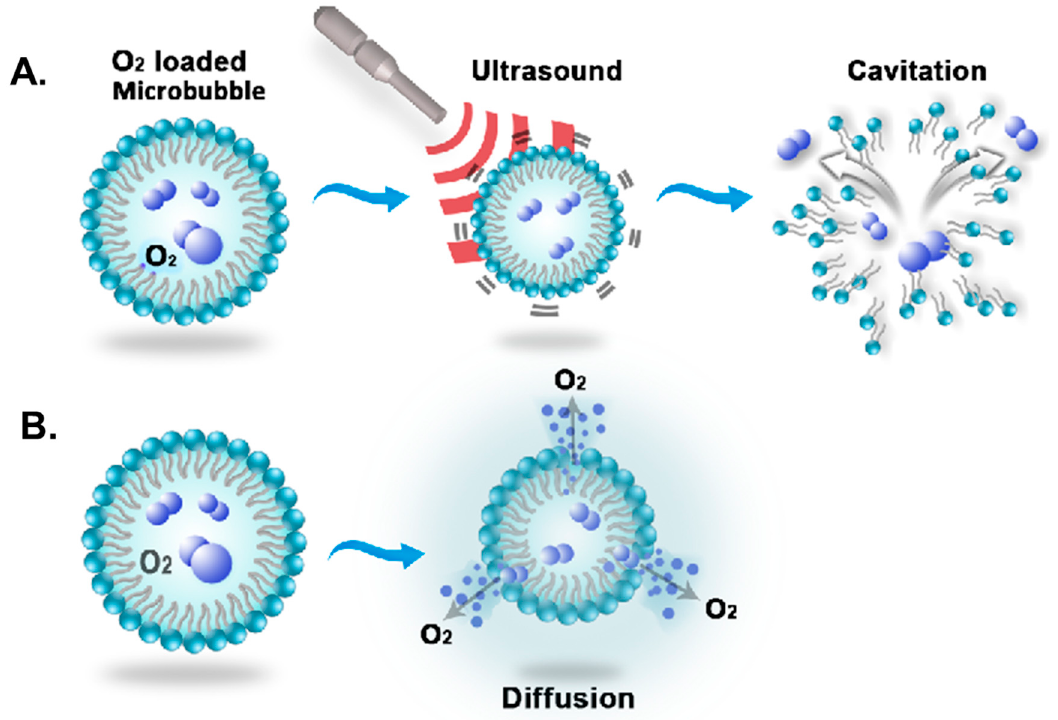
Figure 2. Oxygen delivery mechanism of MNBs: ( A ) MNB disruption using ultrasound and ( B ) diffusion of oxygen across the concentration gradient.